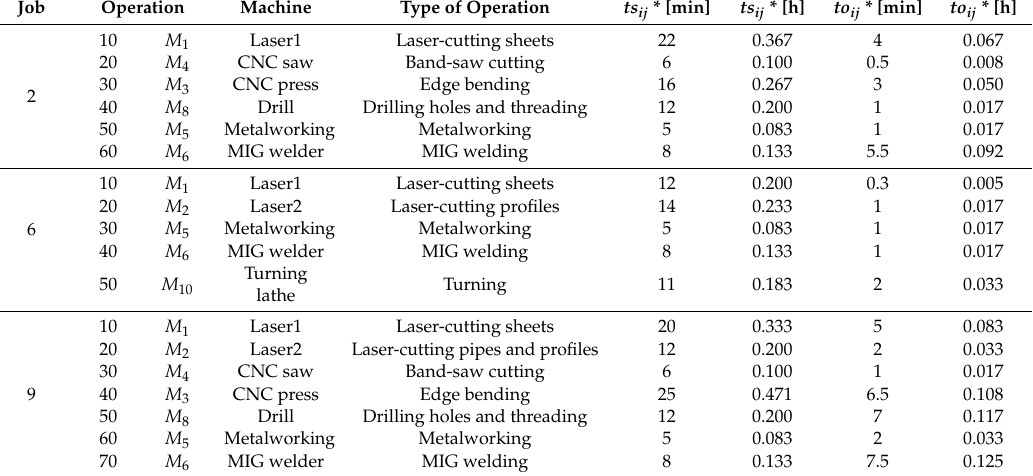
Table 1. Production data implemented in the robust scheduling